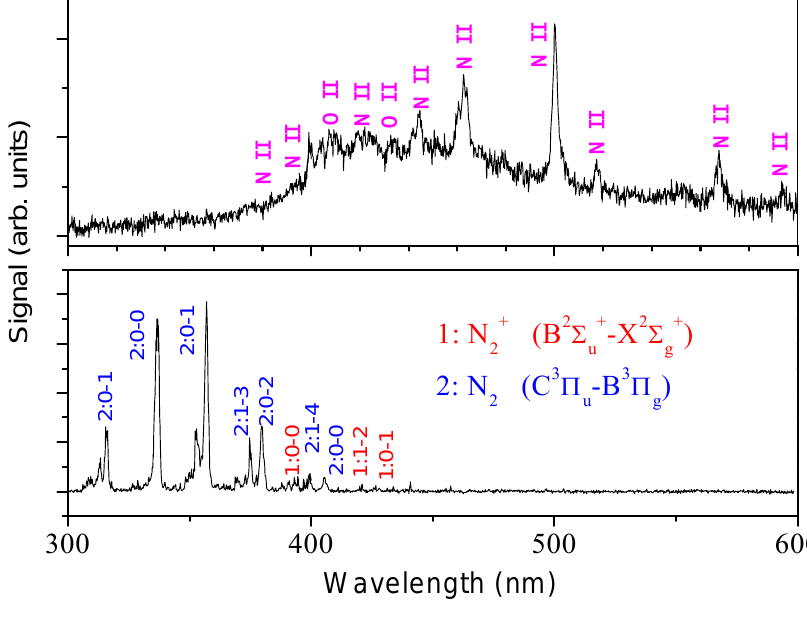
5 mJ. The durations of the short and long laser pulses were 42 fs and 200 ps, respectively. The short and long laser pulses were focused into air respectively by lens with a focal length of f = 100 cm and f = 5 cm. The lines superposed on the continuum shown in the upper spectrum mainly come from the emissions of singly charged nitrogen and oxygen atoms, while the spectral bands shown in the bottom spectrum result from neutral and ionic molecular